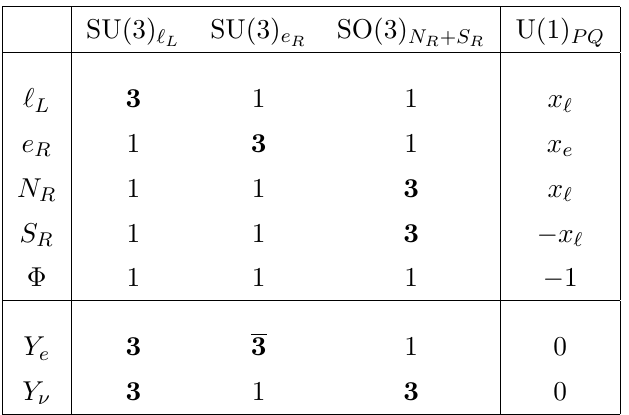
Table 1 . Transformation properties of the SM leptons, exotic neutral leptons and spurions under the global symmetries G SO(3) F